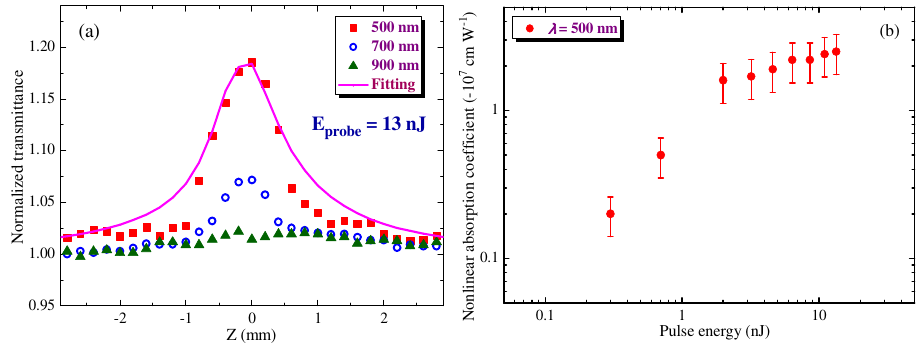
Figure 4. Results of the OA Z-scan studies of HgS QD film. ( a ) OA Z-scans using 500 (red filled squares), 700 (blue empty circles), and 900 nm (green filled triangles) at similar a energy of the probe pulses (13 nJ). Solid curve corresponds to the fitting of the OA Z-scan in the case of 500 nm PP. ( b ) The dependence of the nonlinear absorption coefficient responsible for saturable absorption at λ = 500 nm on the energy of the probe pulses.